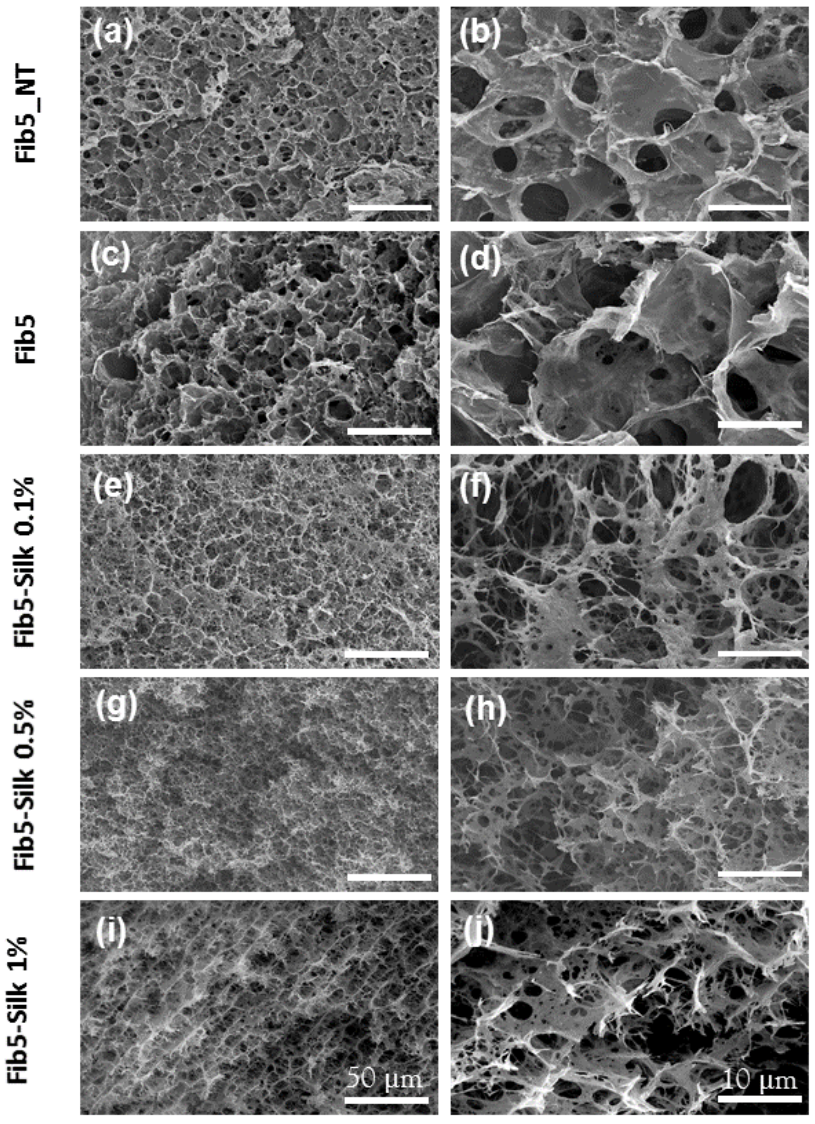
Figure 2. ( a ) Schematic representation of the fabrication process of the composite scaffolds. ( b ) Mac-